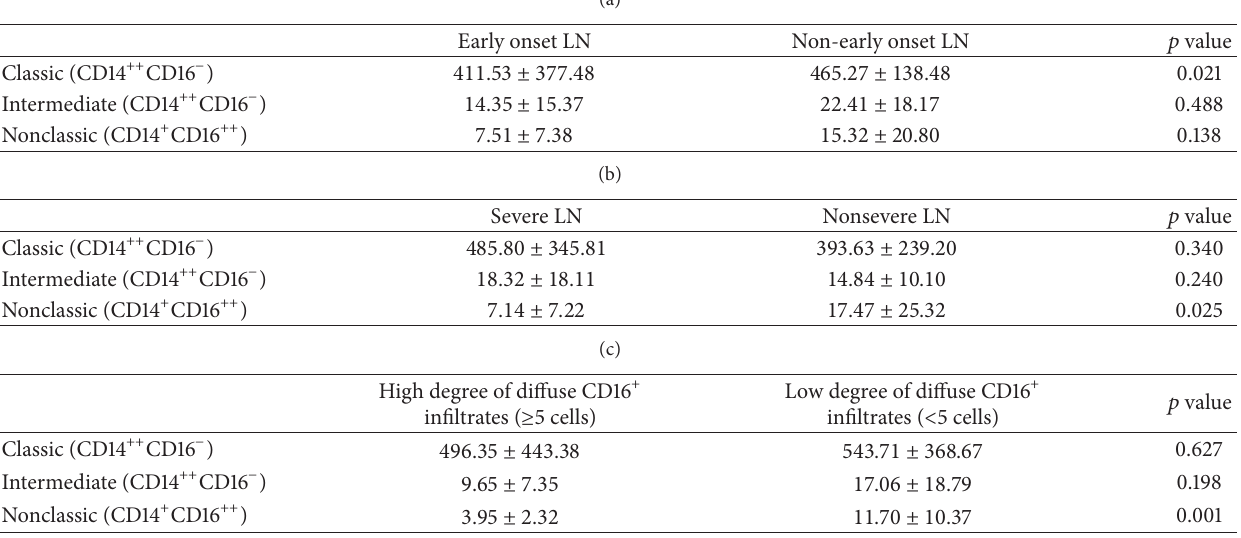
Table 3: Peripheral blood levels of Mo subsets according to disease duration, severity of LN, and degree of infiltrations by CD16 +